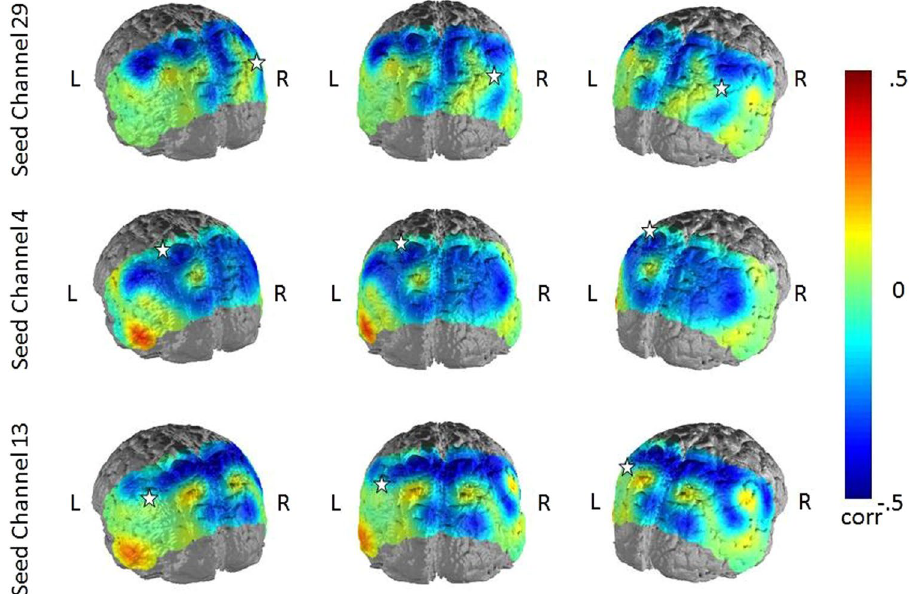
Figure 3. Correlations between trait rumination and FC in the three seed regions of the depression-related network. Seed regions are marked by a white star.